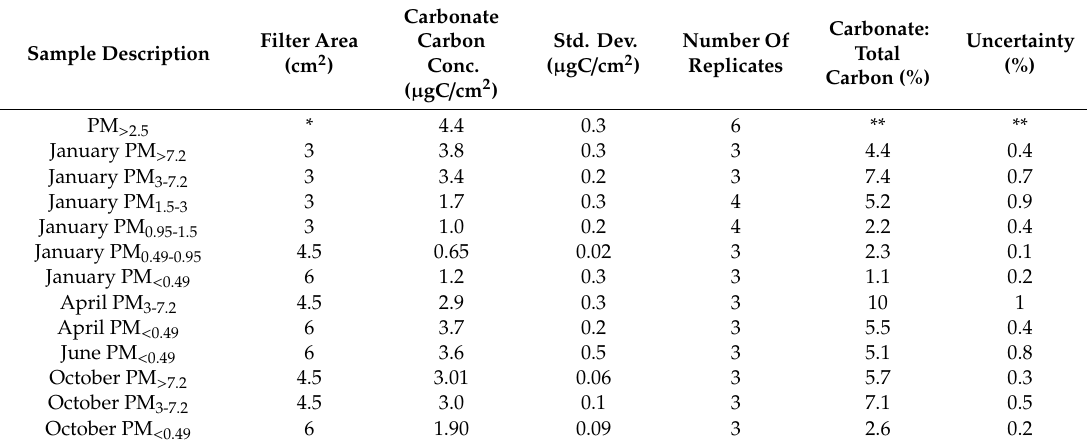
Table 3. Results of carbonate analysis in size-segregated aerosol